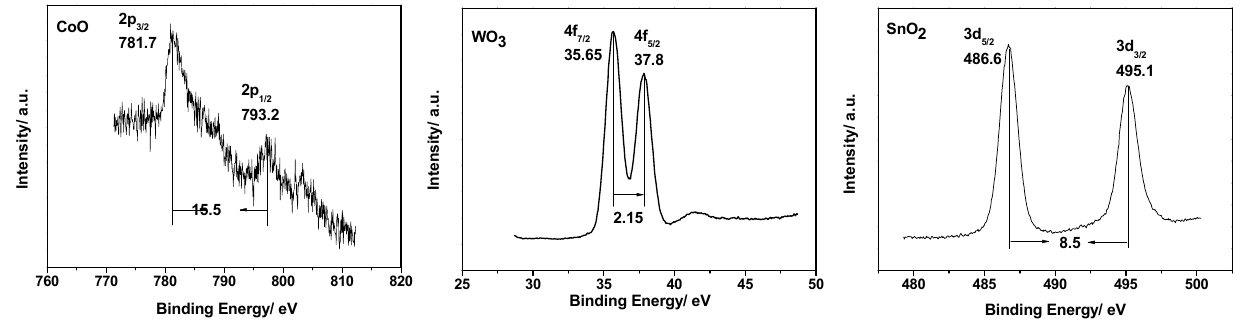
Figure 3. Co 2P, W 4f, and Sn 3d XPS of fresh POM material.